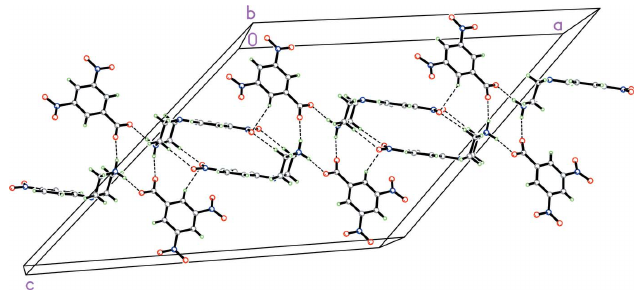
Figure 9 Packing diagram for 3 (only major component shown) showing the complex three-dimensional array of hydrogen bonding involving R 2 (8), 2 R 4 (12) and R 4 (20) rings propagating in the a -axis direction between the 4 4 the 4-nitrophenyl group of one cation with the piperazinium ring of an (cid:3) x , 1 (cid:3) y , 1 (cid:3) z , involving O1 iii and adjacent cation (symmetry code: 1 2 2 O2 iii ; Table 4), two cations and two anions in adjacent asymmetric units ( (cid:3) x , (cid:3) y , 1 (cid:3) z , involving O7 i ), and two cations and two anions in adjacent asymmetric units (symmetry code: (cid:3) 1